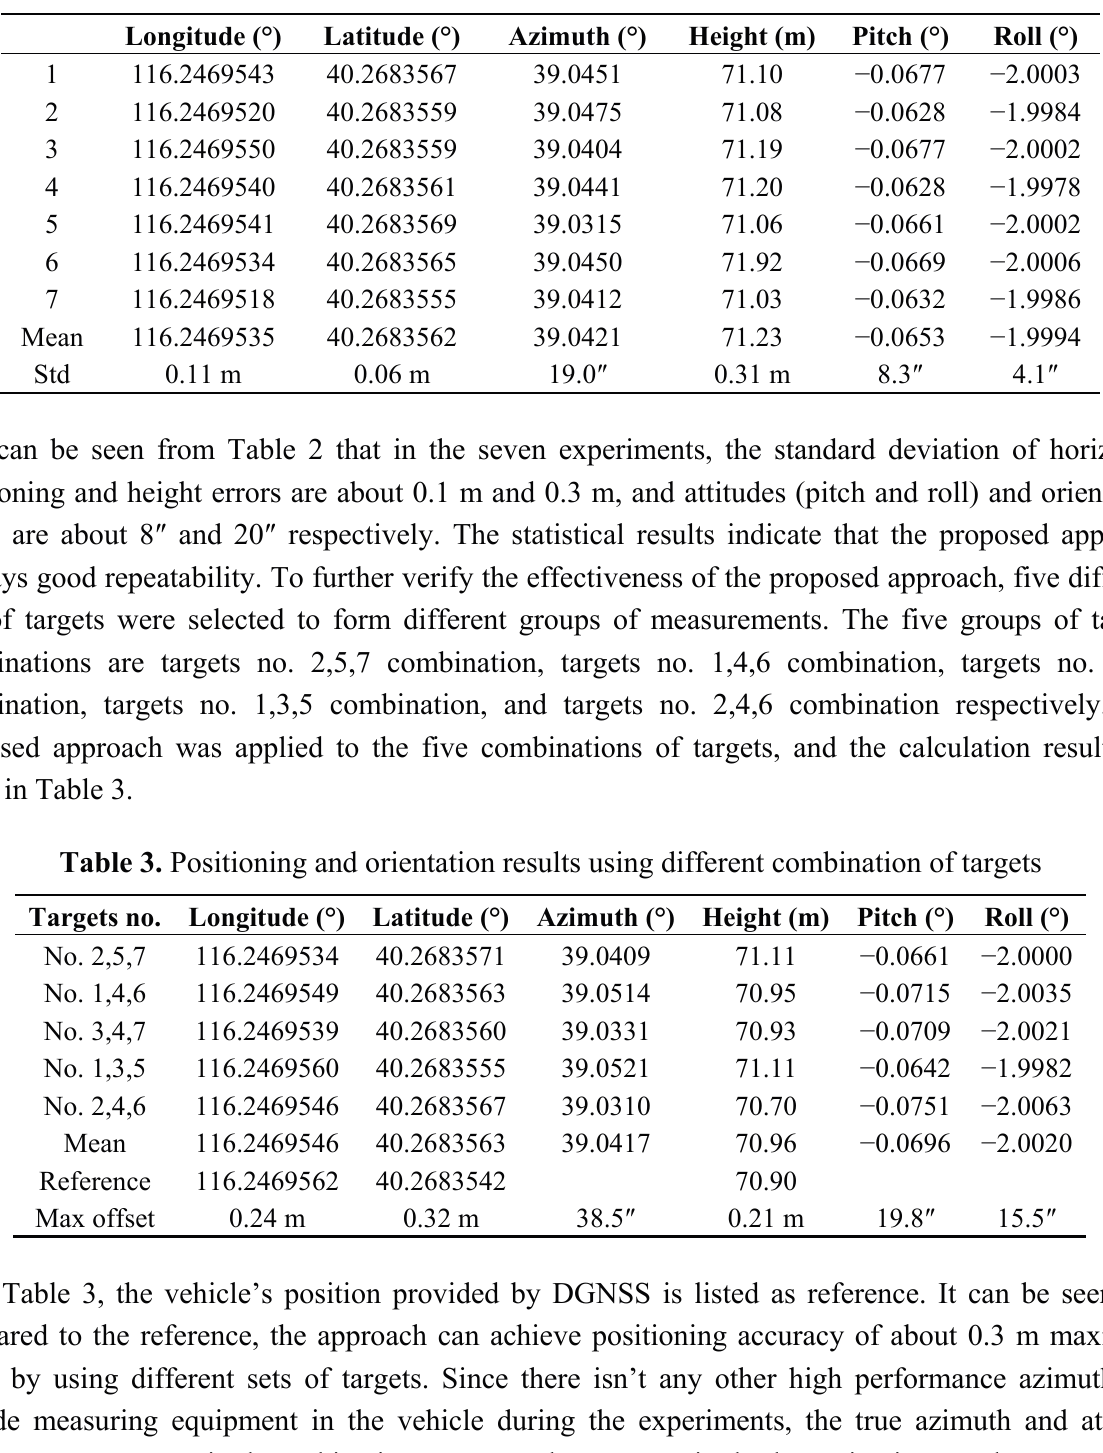
Table 2. Positioning and orientation results